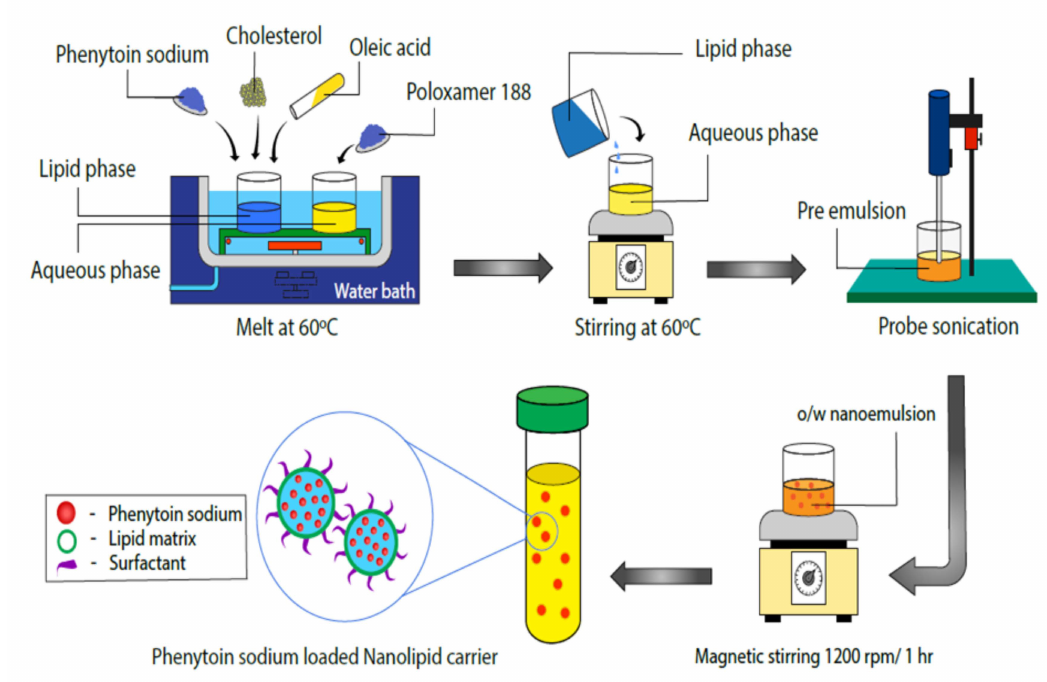
Figure 1. Schematic representation of method of preparation of phenytoin sodium loaded